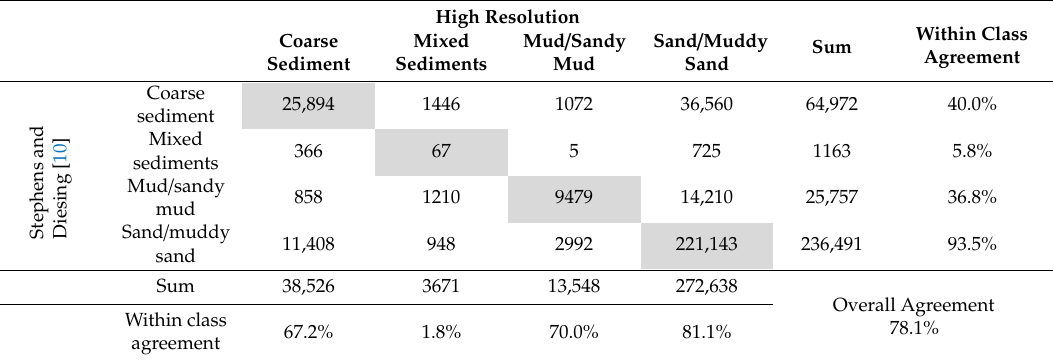
Table 4. Comparison of high-resolution map with sediment map from Stephens and Diesing [10]. Cells indicating map agreement are highlighted in grey.